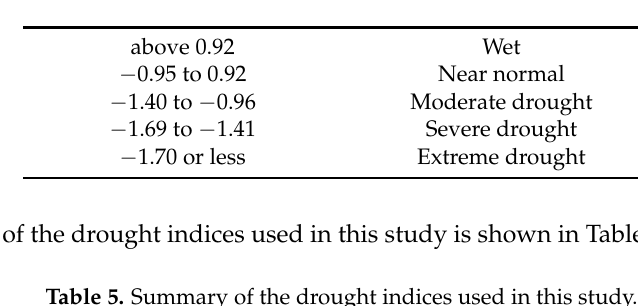
Table 4. Aggregate drought index (ADI) drought category classification.